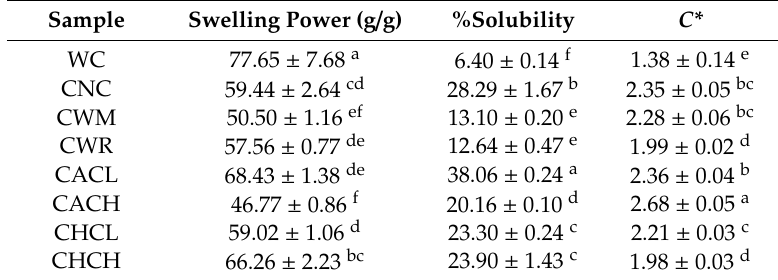
Results are mean ± S.D.; values followed by di ff erent superscripts within the same column are significantly di ff erent (p ≤ 0.05).